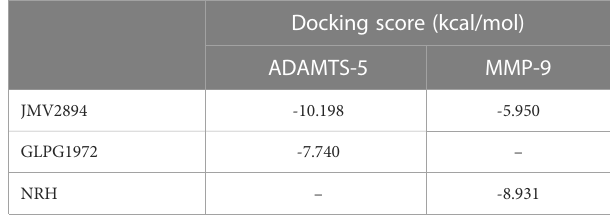
TABLE 1 Docking score of JMV2894 towards ADAMTS-5 and MMP-9 crystal structures expressed as kcal/mol.